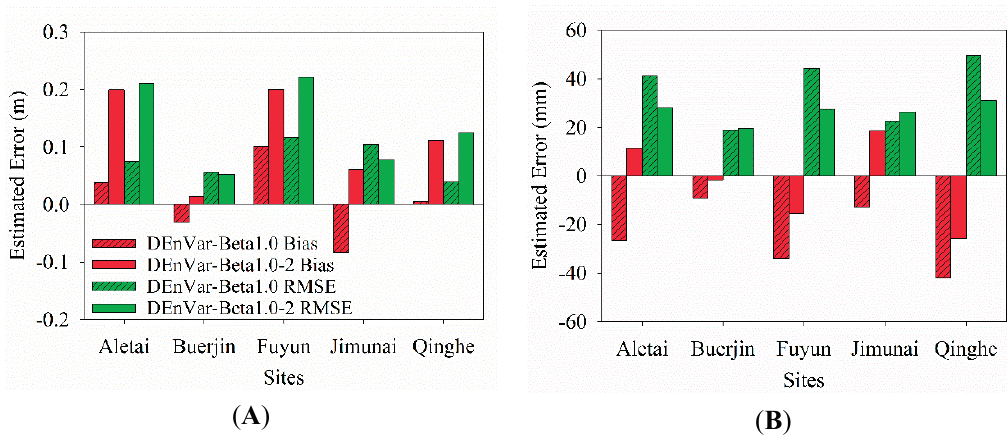
Figure 10. The bias and RMSE of the analyzed SD ( A ) and SWE ( B ) in DEnVar-Beta 1.0–2 experiment with the MODIS SCF observation error of 10%.